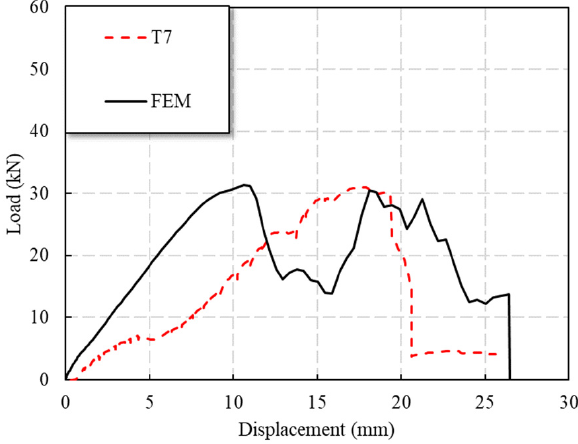
Figure 13. Comparison of ( a ) shear stress predicted by FE model, and ( b ) shear out failure mode of specimen T7.